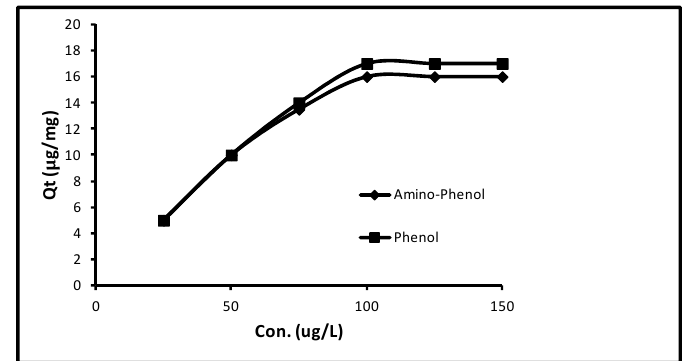
Figure 2. E ff ect of initial concentrations of